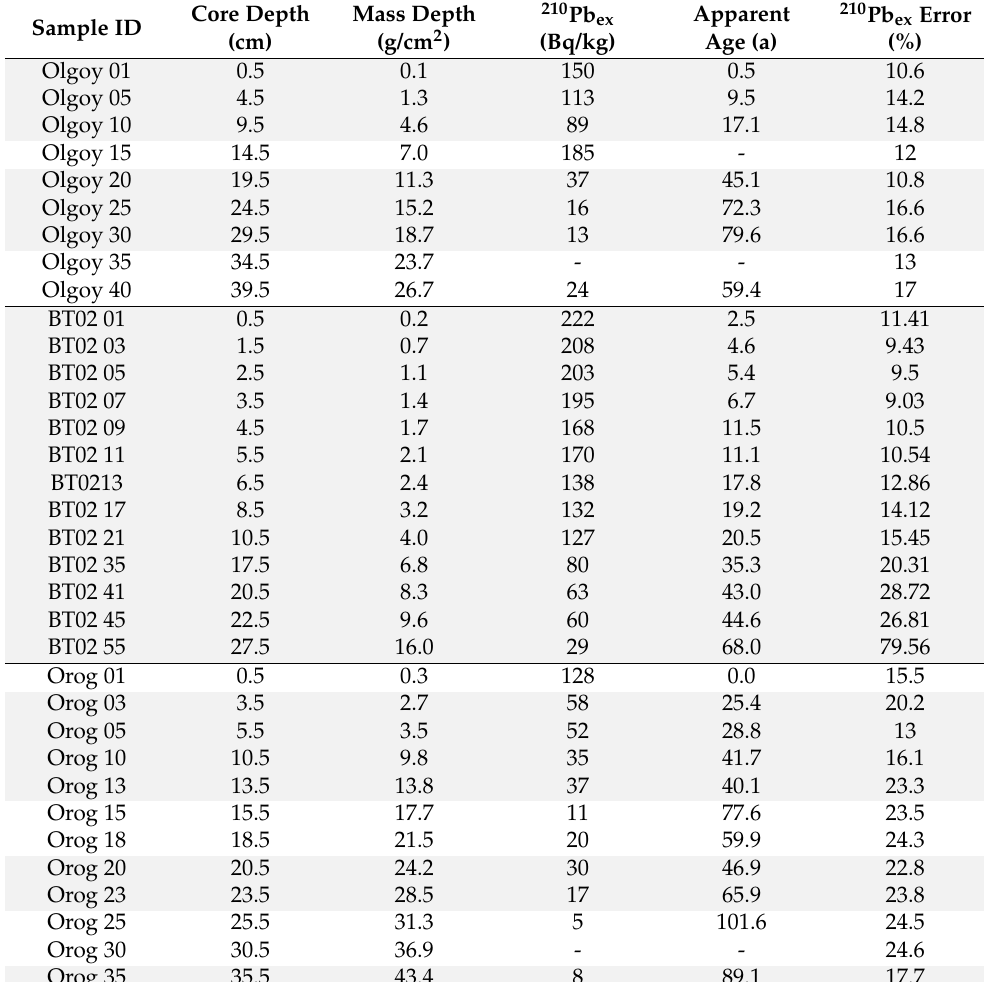
Table 2. Excess 210 Pb results from Olgoy, Boontsagaan, and Orog Lakes. (Ages are calculated under the assumption of constant initial radioactivity). Shaded data are utilized to calculate the sedimentation